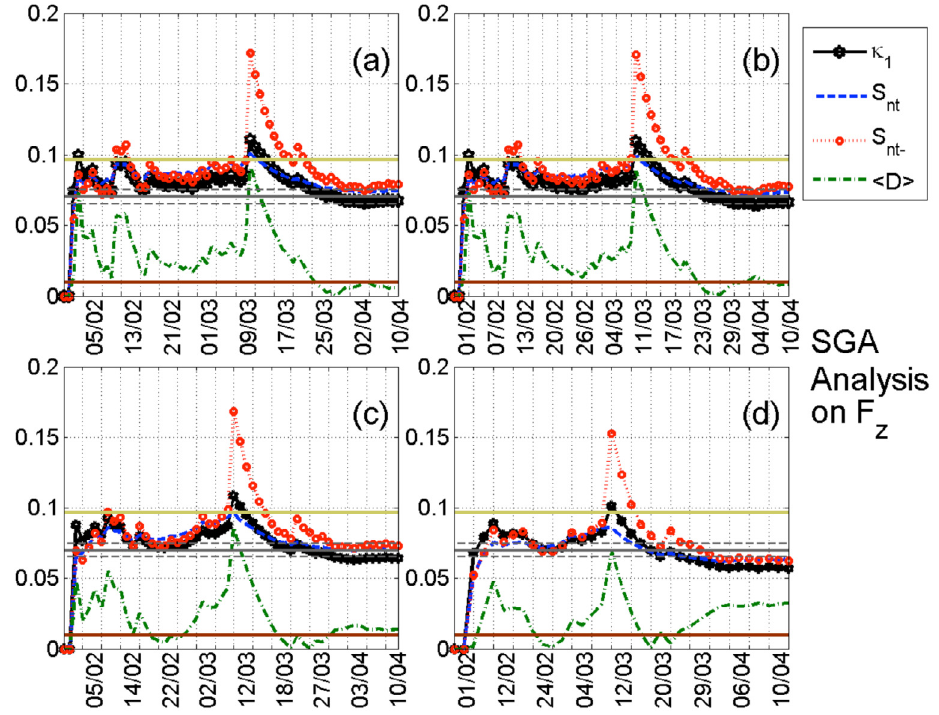
at SGA for the time period from February 1 to April 12, z 0.00000, 0.00250, 0.00375, and 0.00500, re- z,thres